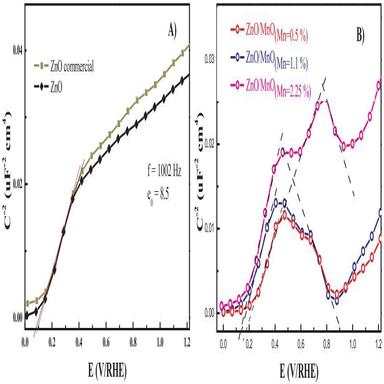
Mott-Schottky plots for (A) ZnO and (B) n-ZnO/p-MnO nanocomposite, recorded in 0.1 M NaOH electrolyte, f = 1.002 Hz, ε = 8.5 (for all materials).